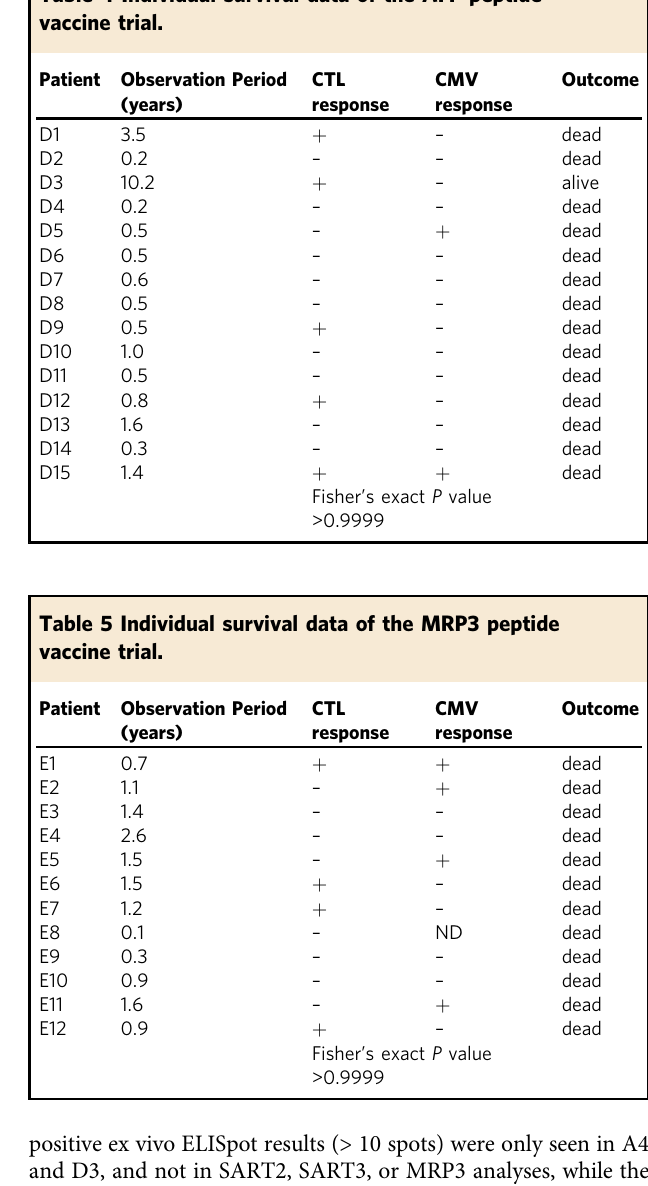
Table 4 Individual survival data of the AFP peptide